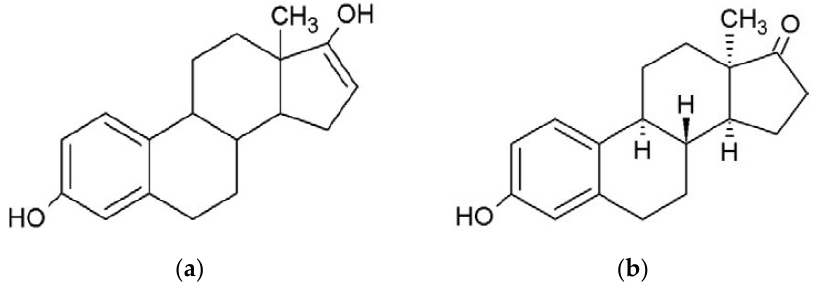
Figure 9. The possible structures of E2 and E2 degradation products: ( a ) P1; ( b ) lumiestrone.